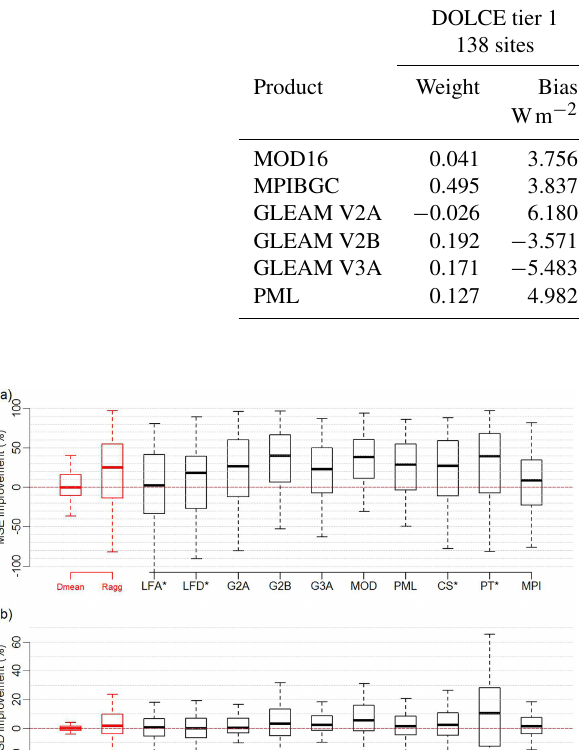
Table 3. (1) Bias of weighting products and (2) weights assigned to the bias-corrected products in the case of each of the three DOLCE tiers, and the number of flux tower sites used to feed the weighting.